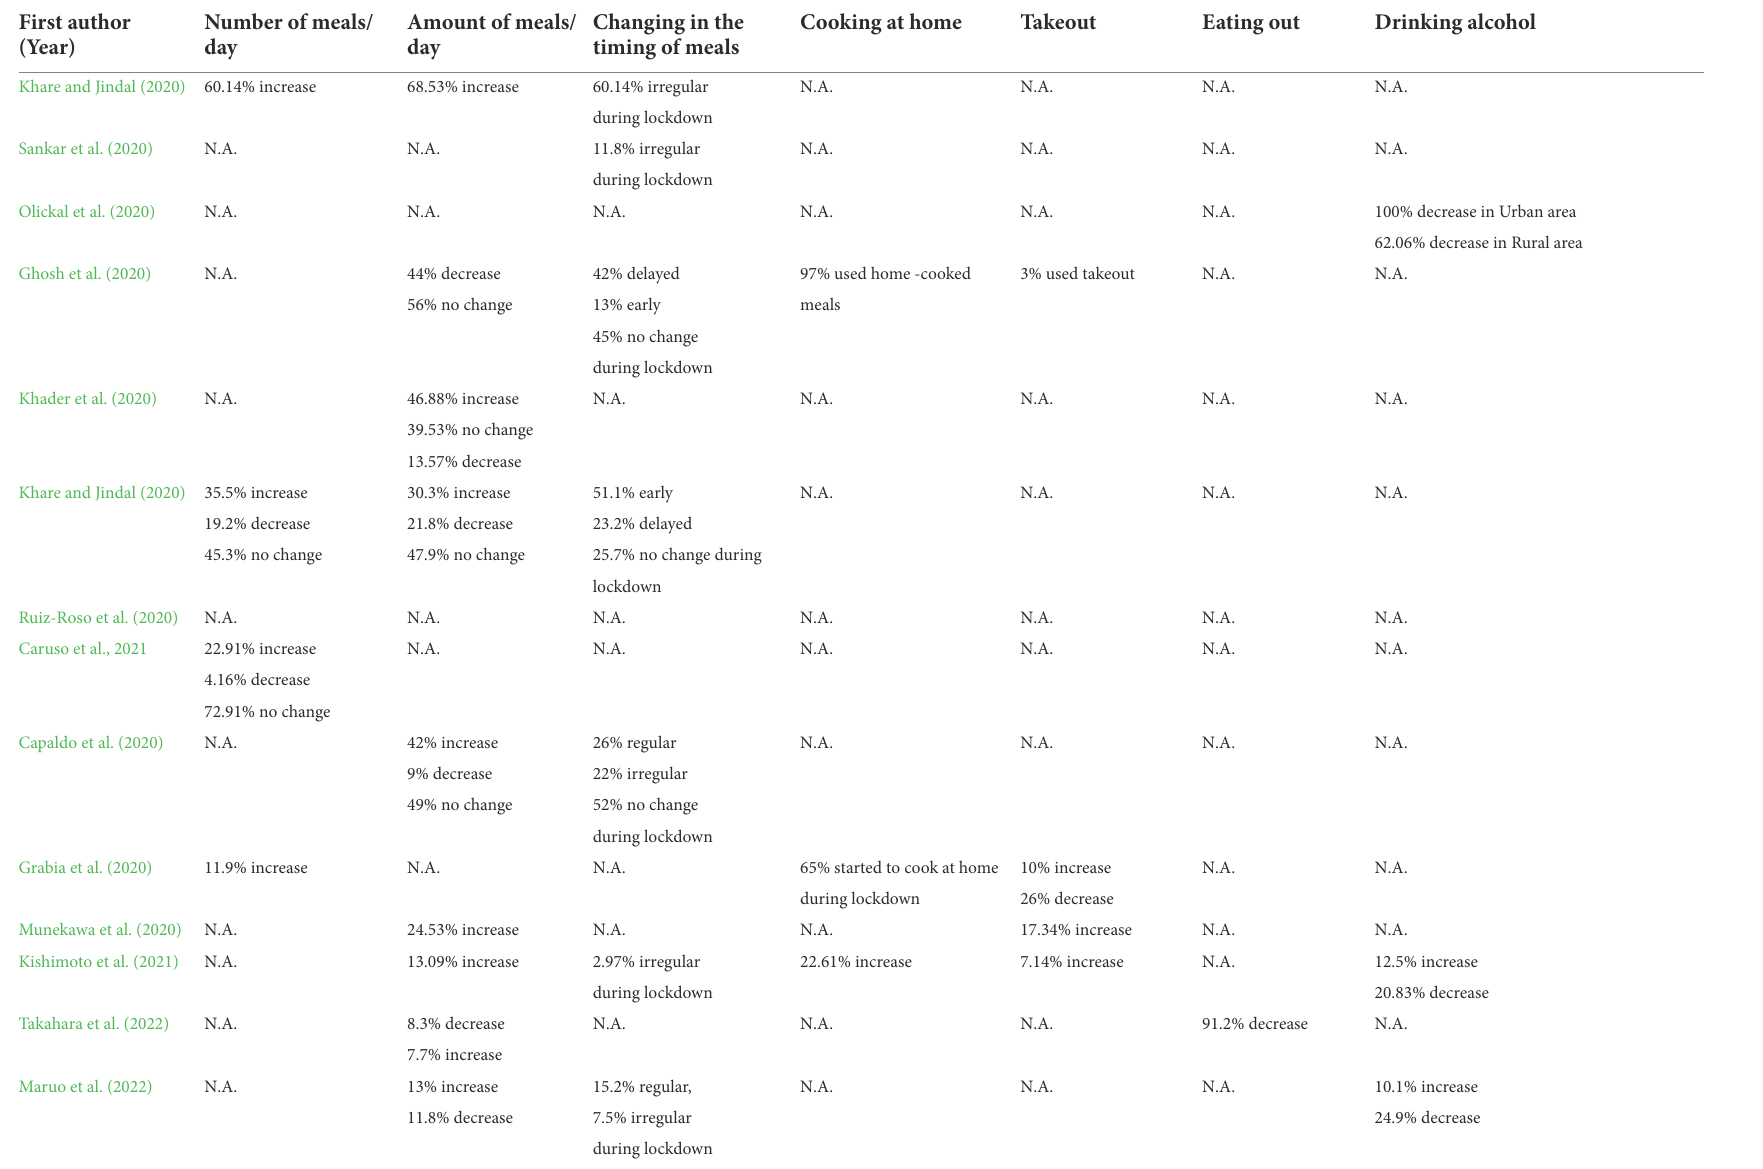
TABLE 2 Changes in the eating habits of diabetic patients during COVID-19 lockdown and social